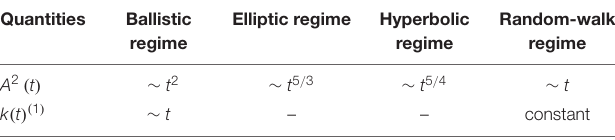
TABLE 1 | Classical absolute dispersion regimes.